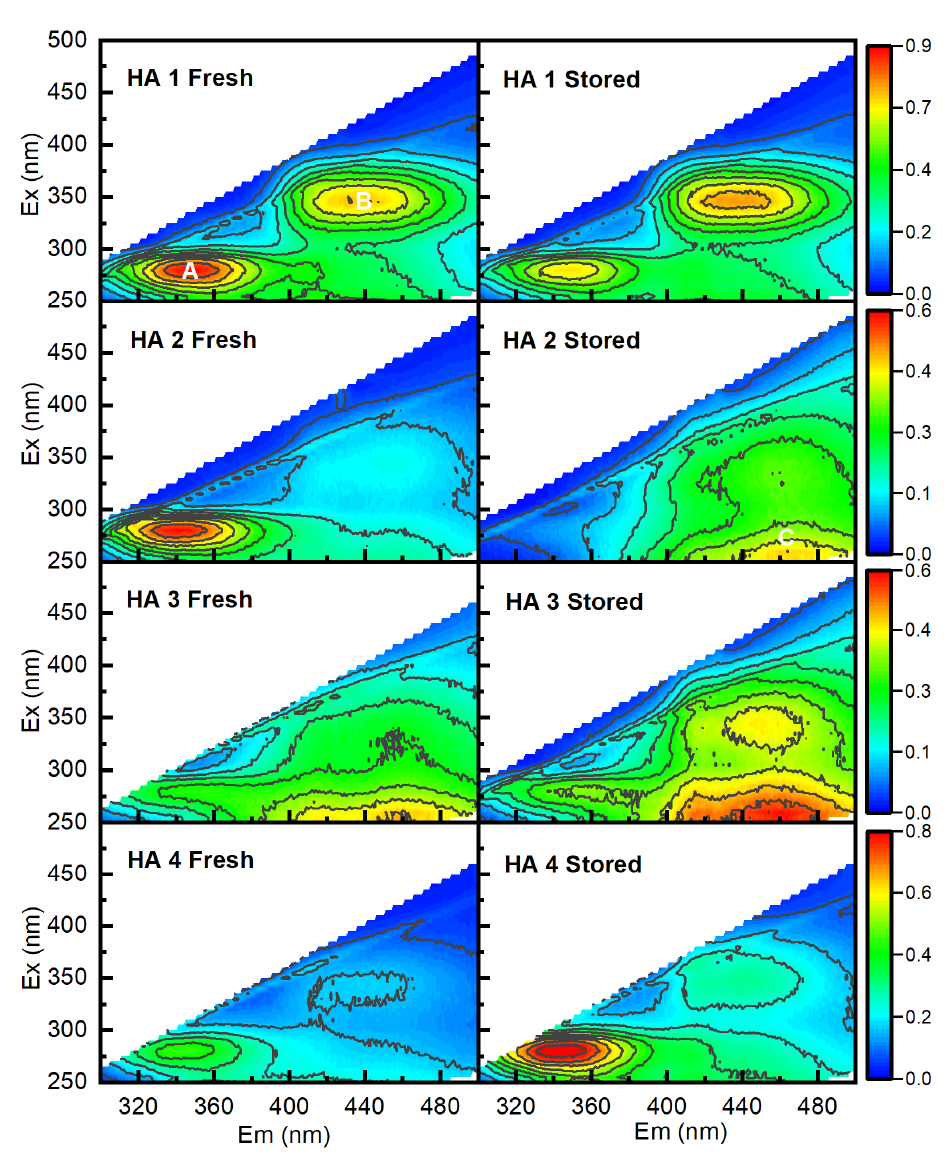
Figure 4. EEM fluorescence spectra of HA extracted from sewage sludge samples. Letters indicate the considered